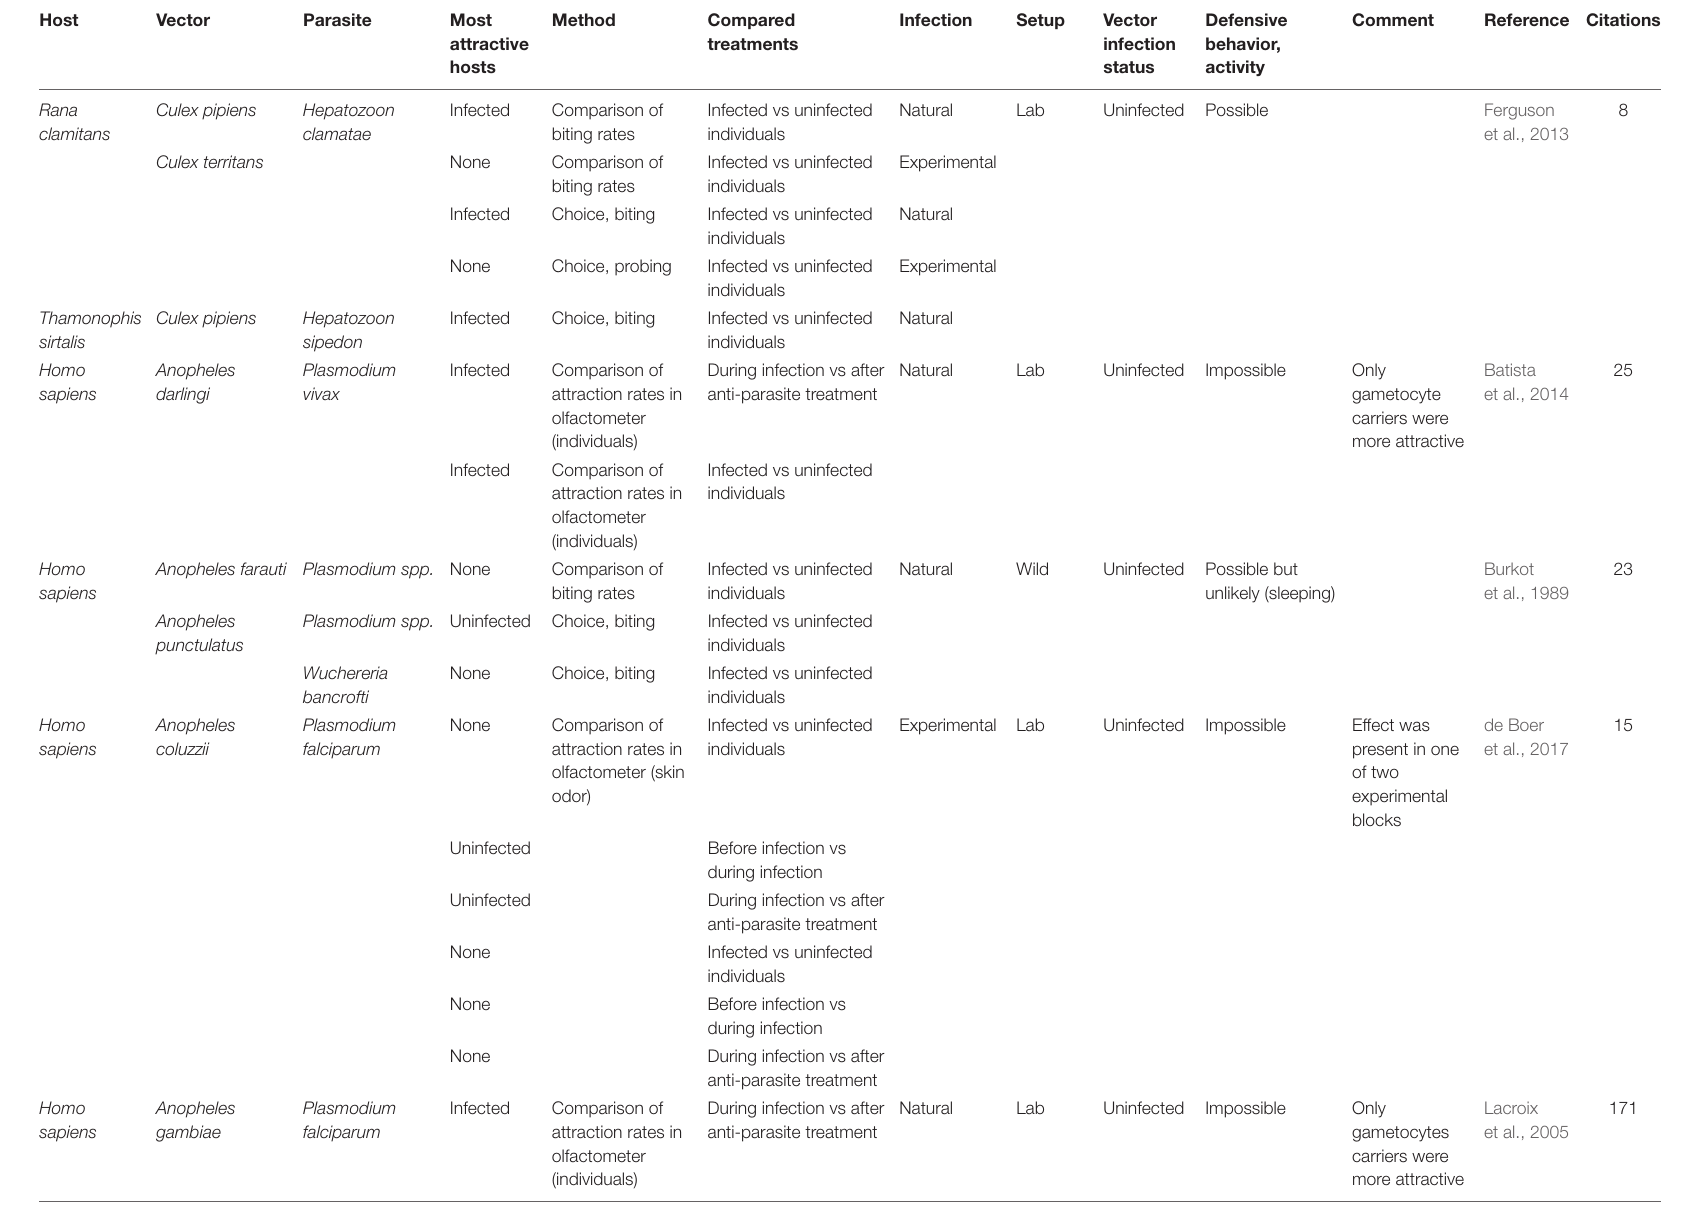
TABLE 1 | Summary of studies comparing attractiveness of infected and uninfected hosts to